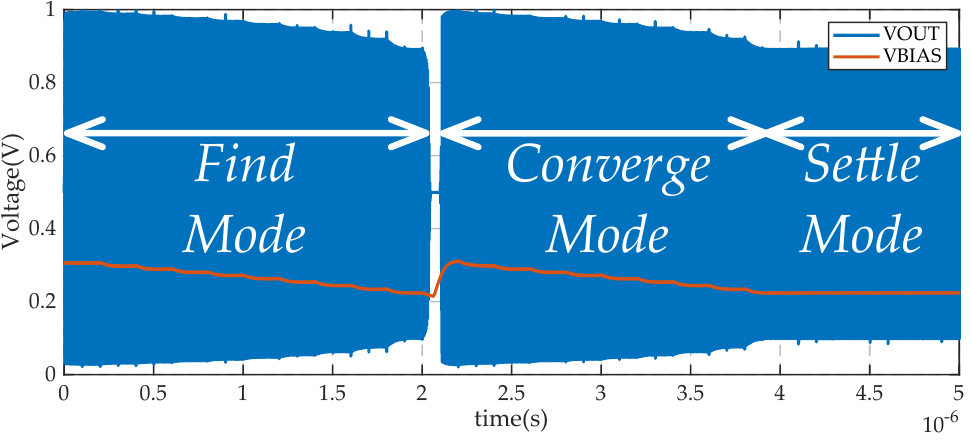
Figure 6. Transient response of VCO with bias